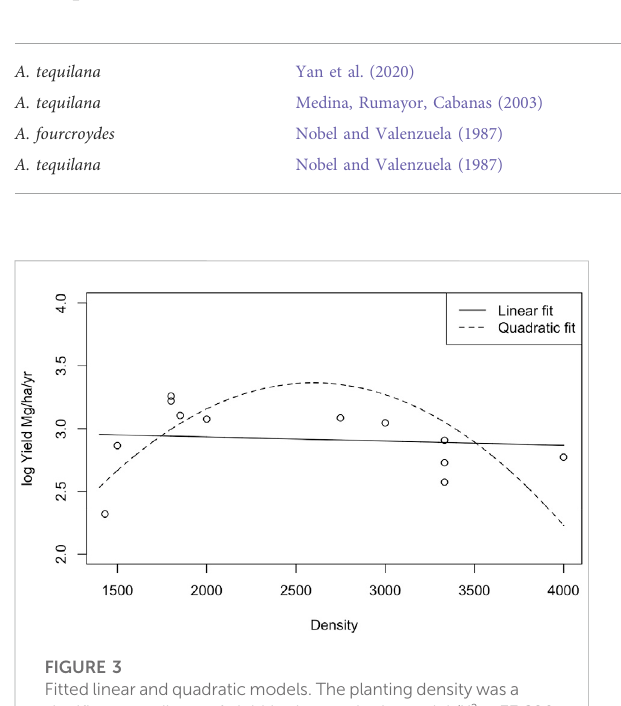
TABLE 4 Data points that achieved a productivity greater than or equal to 21 Mg ha − 1 yr − 1 , as Nobel (1988) predicted would be the maximum for A. tequilana and A. fourcroydes . A. salmiana and A. mapisaga data were excluded because they were not included in the Nobel ’ s ray-tracing model. CAM plant